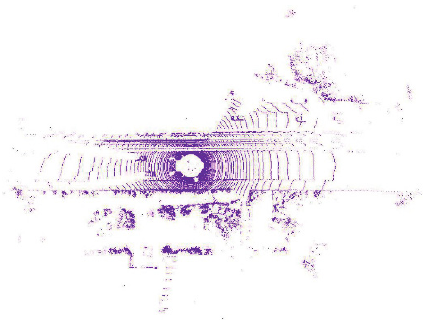
Figure 5. Point cloud data before filtering.